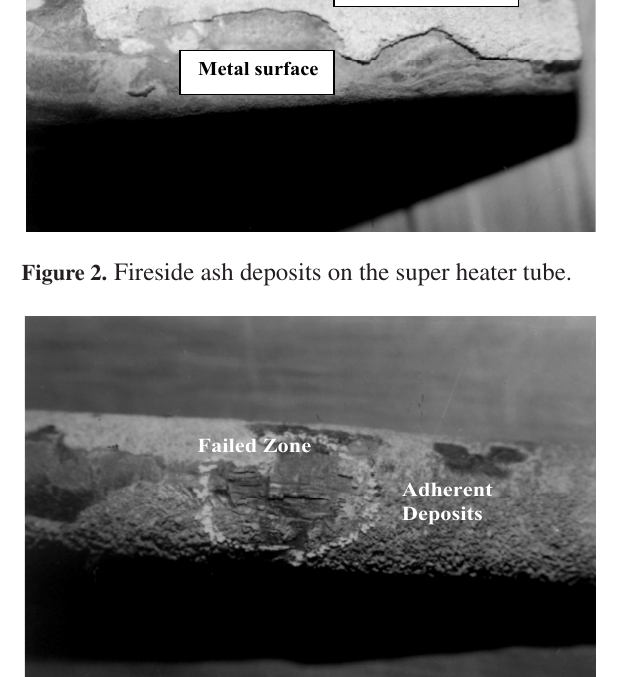
Figure 3. Typical premature high temperature corrosion failure of superheater tube.